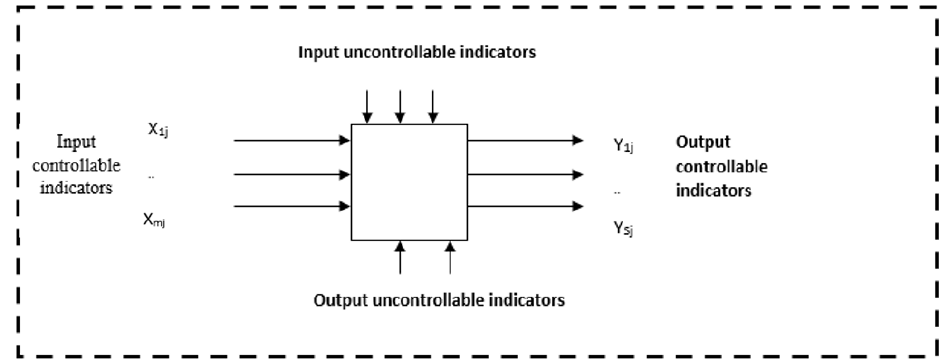
Figure 6. Data envelopment analysis and the integrated scorecard model with uncontrollable data.